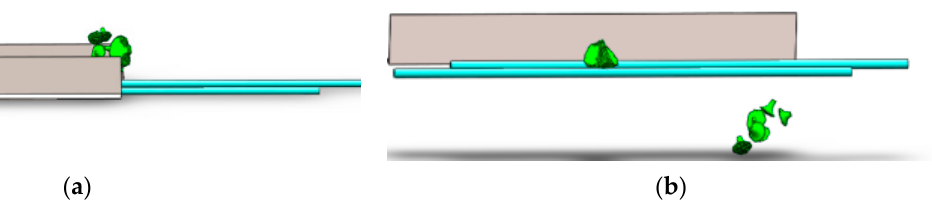
Figure 9. Blocks stacked screening simulation analysis figures, respectively, the blocks attitude at the beginning of simulation ( a ) and at the end of 2s simulation ( b ).